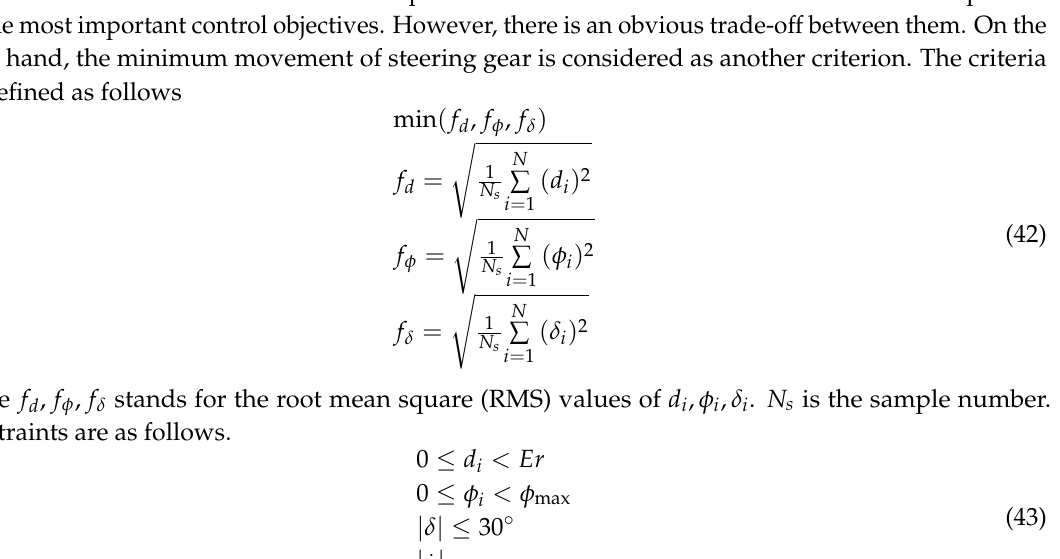
Figure 5. The restrictions of model perturbation, external disturbance and the performance trade-off. Multi-objective optimization methods have been applied to solve many engineering problems.